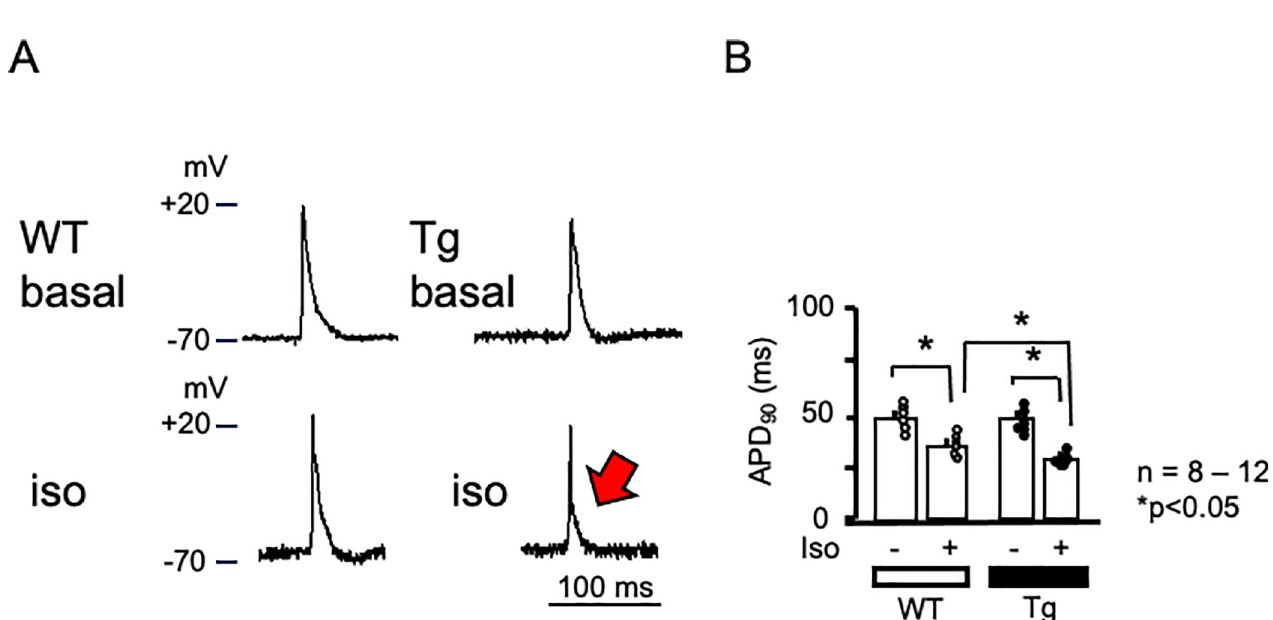
Fig 5. Action potential in atria. A) Representative action potentials of atrial sinus nodes in WT and PKD2L1del-Tg mice. Basal action potential changes in WT and Tg mice are shown (upper panels). Action potential changes are shown in response to isoproterenol (100 nM, lower panels). B) Statistical analysis of the atrial action potential duration at 90% repolarization in WT and Tg mice. Atria from Tg mice showed a shortened action potential duration (red arrow). n = 8–12. P <